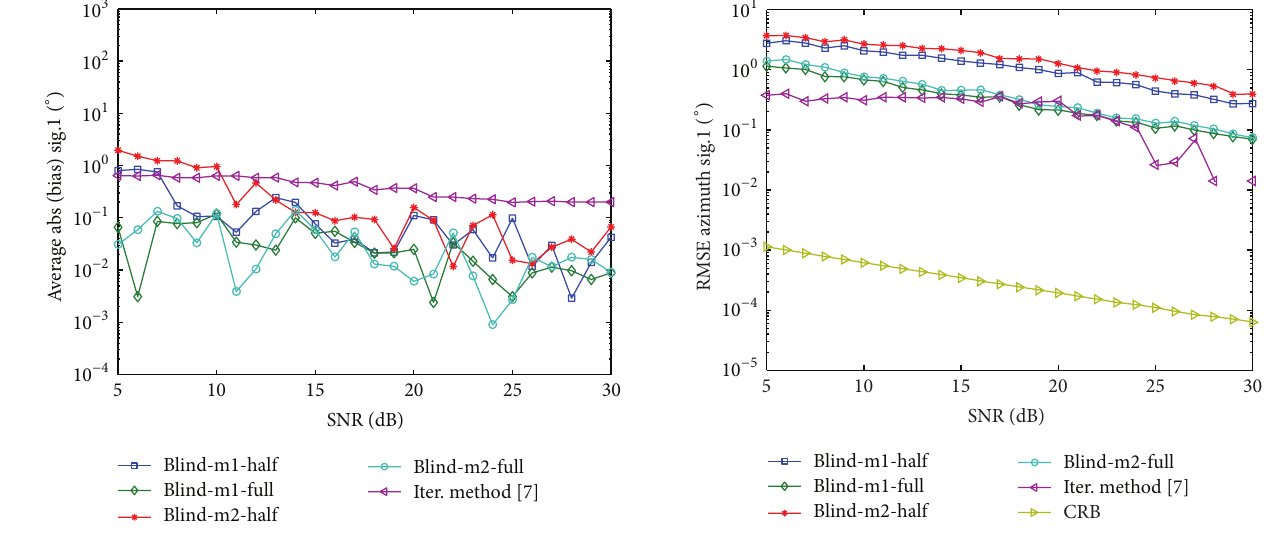
Figure 3: Average DOA absolute bias versus SNR for signal 1.